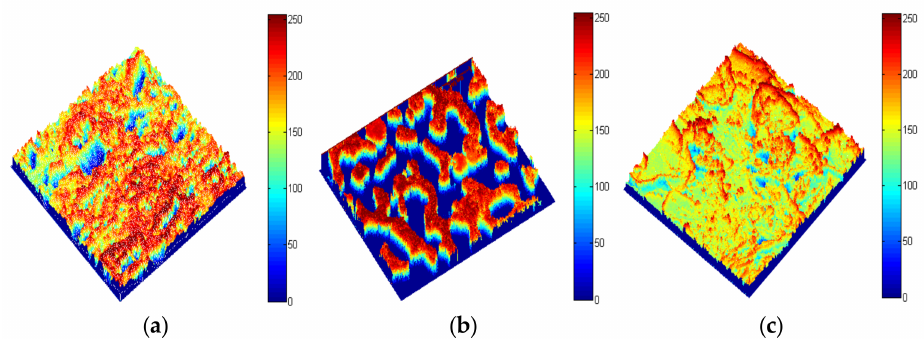
Figure 7. Three dimensional optical enhancement diagram of coral reef multi-scale pore structure. ( a ) Macroscale image; ( b ) Mesoscale image; ( c ) Microscale image.